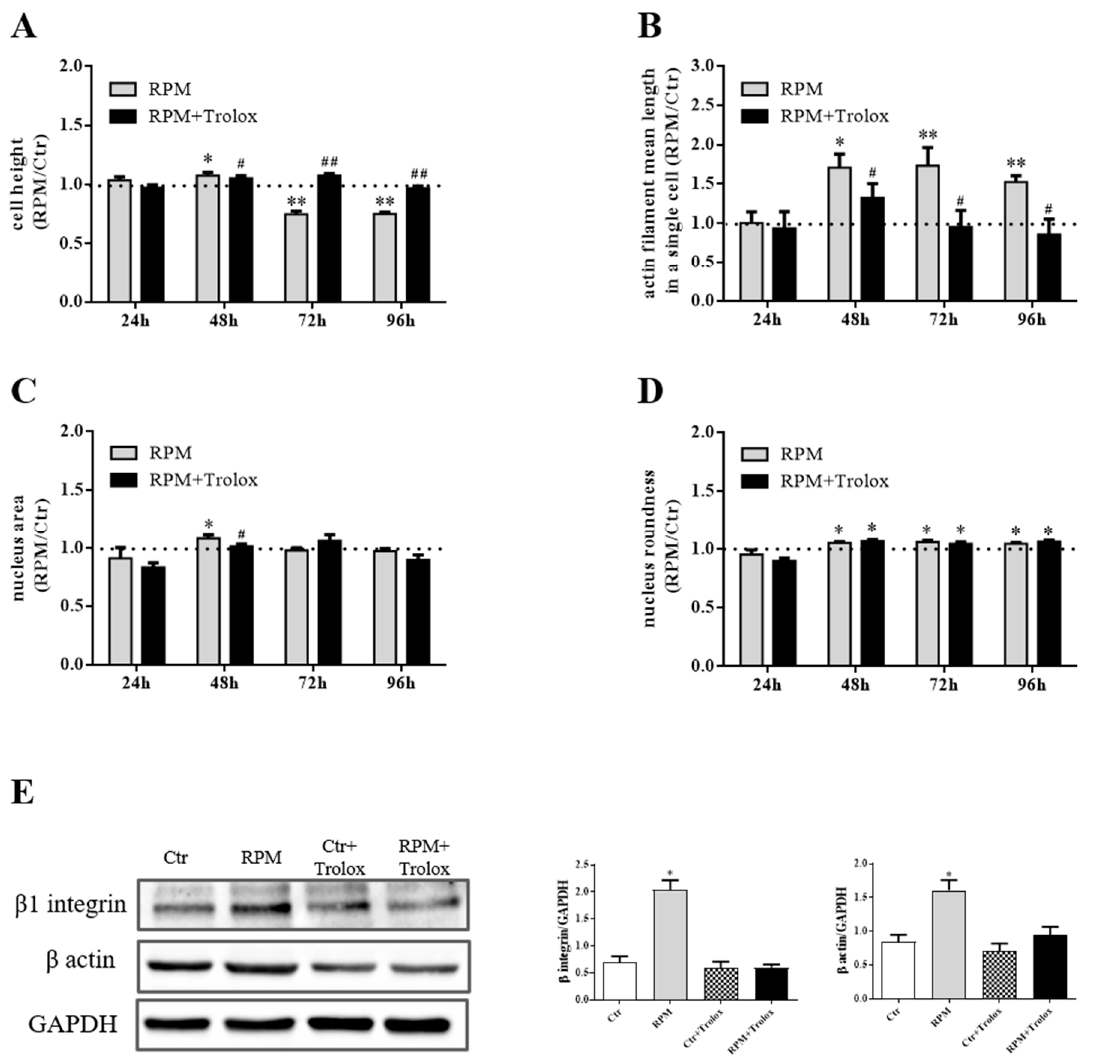
Figure 5. Trolox’s e ff ects as countermeasures to biological changes induced by s-microgravity. ( A , B ) Cell height and mean length of actin filaments of cells exposed to s-microgravity up to 96 h of cell culture with (RPM + Trolox) or without (RPM) 100 µ M Trolox. ( C , D ). Quantitative analyses of nuclei area and roundness of the RPM and RPM + Trolox cells up to 96 h of cell culture. The data A–D are presented as the ratio between each parameter and the respective control (dashed line) at each time point. ( E ) Representative immunoblots β 1 integrin and β actin expression levels and the corresponding densitometric analyses of the 1g controls cells without (Ctr) or with 100 µ M Trolox (Ctr + Trolox), and s-microgravity-exposed cells without (RPM) or with (RPM + Trolox) 100 µ M Trolox up to 24 h of cell culture. The densitometric analyses are plotted as the relative expression calculated as the ratio between the optical density (OD) × mm 2 of each band and OD × mm 2 of the corresponding anti-glyceraldehyde-3-phosphatedehydrogenase (GAPDH) band, used as loading control. In all graphs, the data are presented as the means ± SEM from three independent experiments. * p < 0.05, ** p < 0.01 vs. respective Controls ; # p < 0.05, ## p < 0.01 vs . RPM + DMSO . See the complete data sets and detailed statistical analyses, reported in Supplementary Tables (Tables S6–S10 and Western blot analysis).